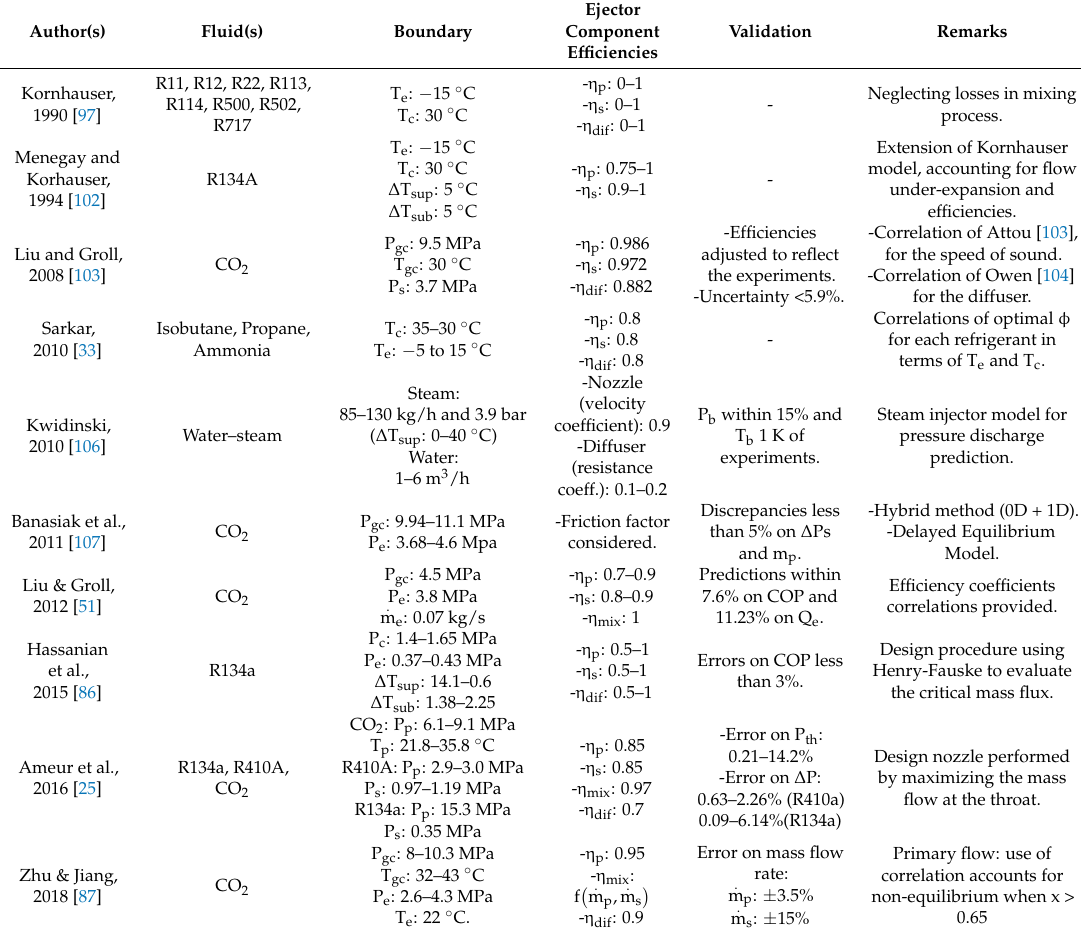
Table 1. Ejector global